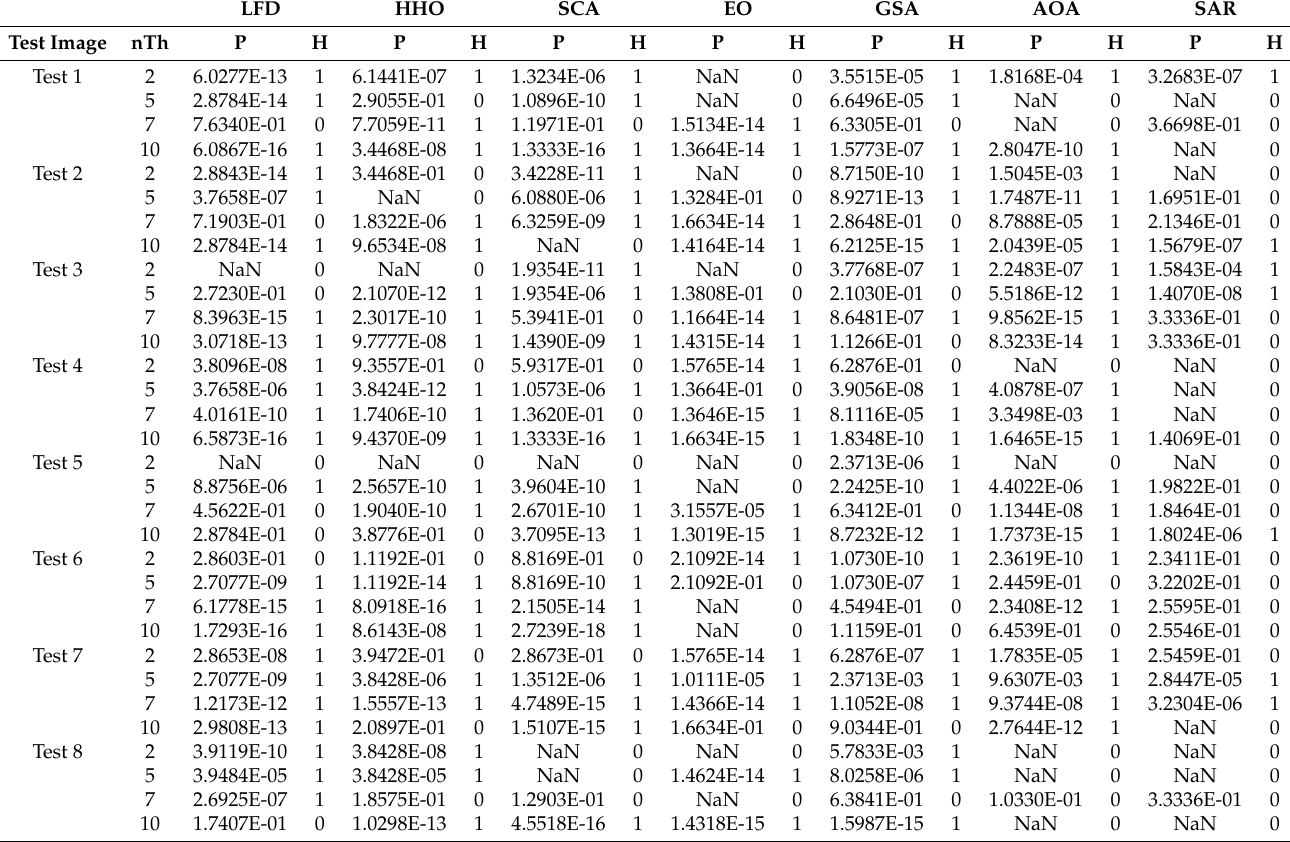
Table A2. Comparison of the p -value and H-value obtained by the Wilcoxon signed-rank test between the pairs of mSAR vs LFD, mSAR vs HHO, mSAR vs SCA, mSAR vs EO, mSAR vs GSA, and mSAR vs AOA for fitness outcomes using Fuzzy Entropy’s